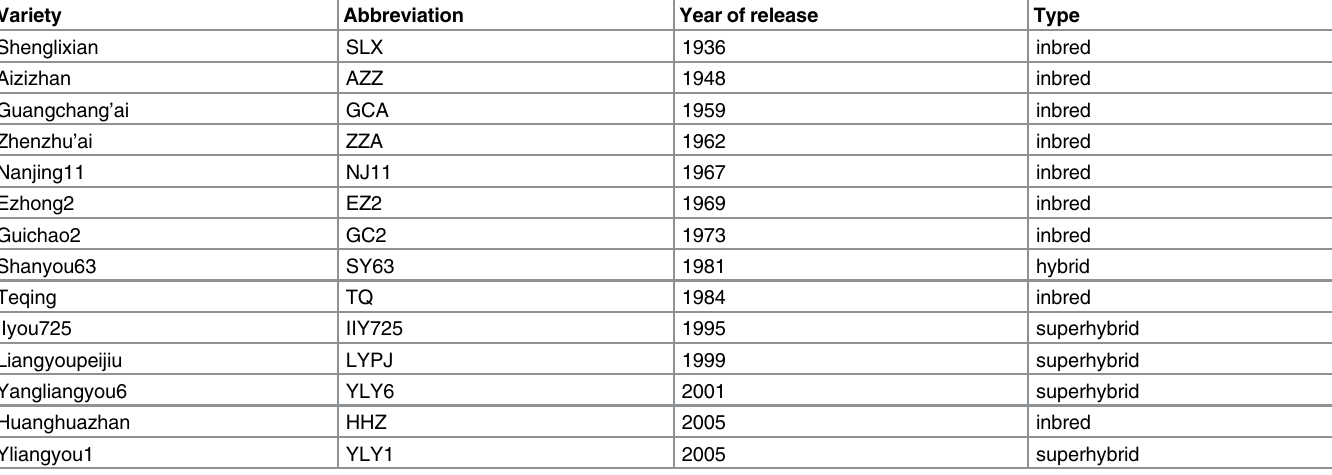
Table 1. Information of rice varieties released in different ages since 1930s in China.